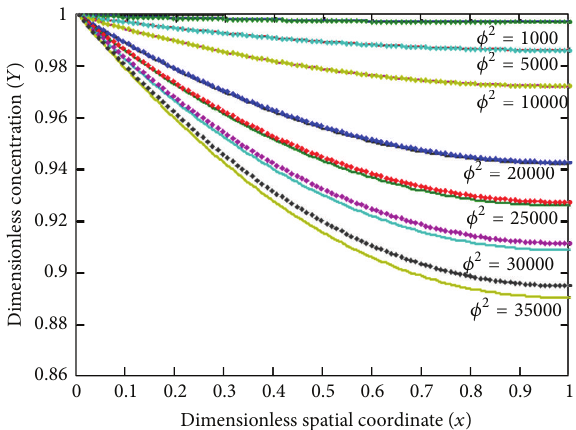
Figure 1: Dimensionless concentration Y versus dimensionless spatial coordinate x using (5) for Le = 0.233, 𝛽 = 4.287, 𝛾 = 13.6, and various values of 𝜙 2 . Solid lines represent the analytical solution, whereas the dotted lines are for the numerical